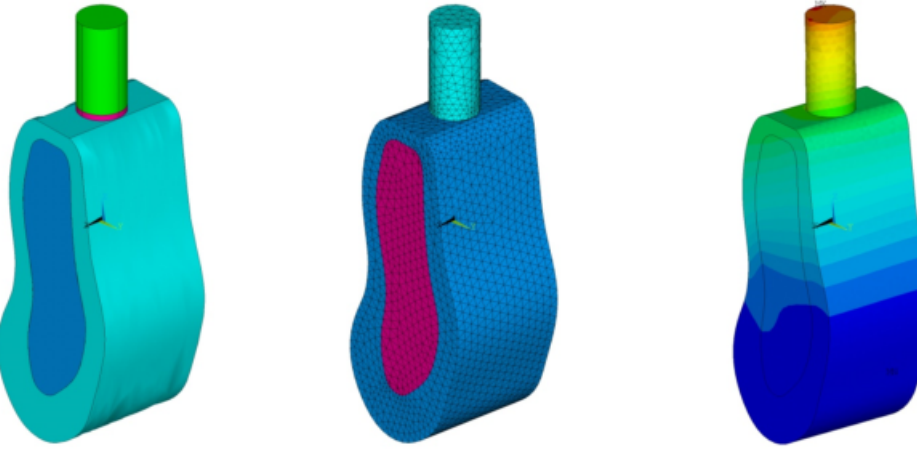
Figure 2. Numerical model of the mandible block which supports the intraosseous part of the implant stem – volumetric model (left), FEM mesh (middle) and total deformation isolines (right).